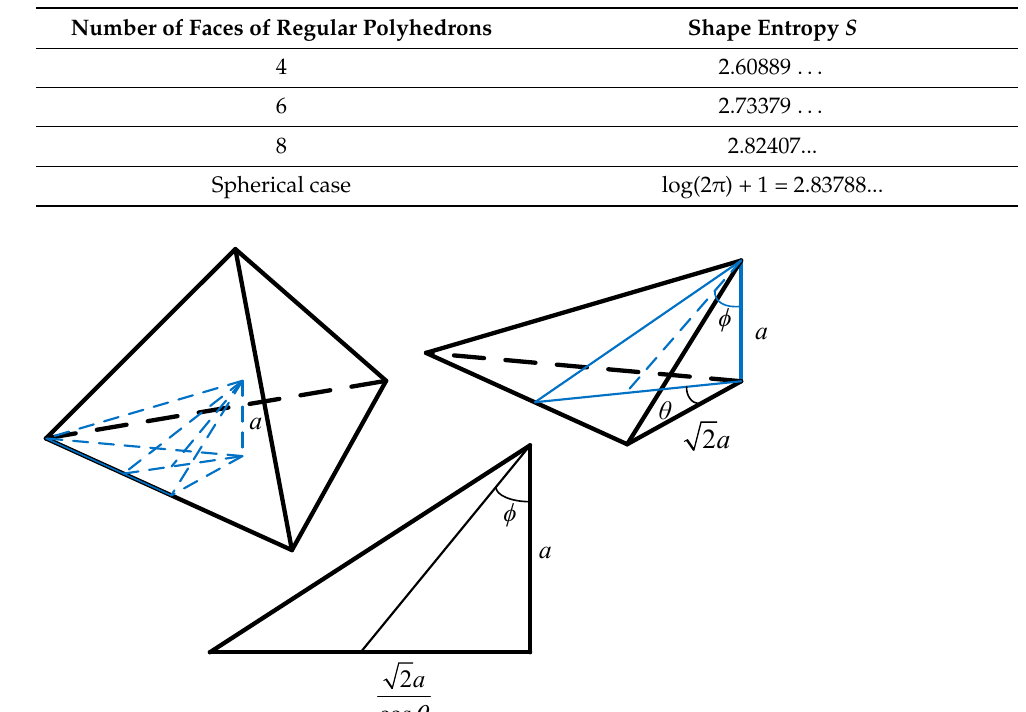
Figure 6. An illustration of a regular tetrahedron and the calculation of its shape entropy.